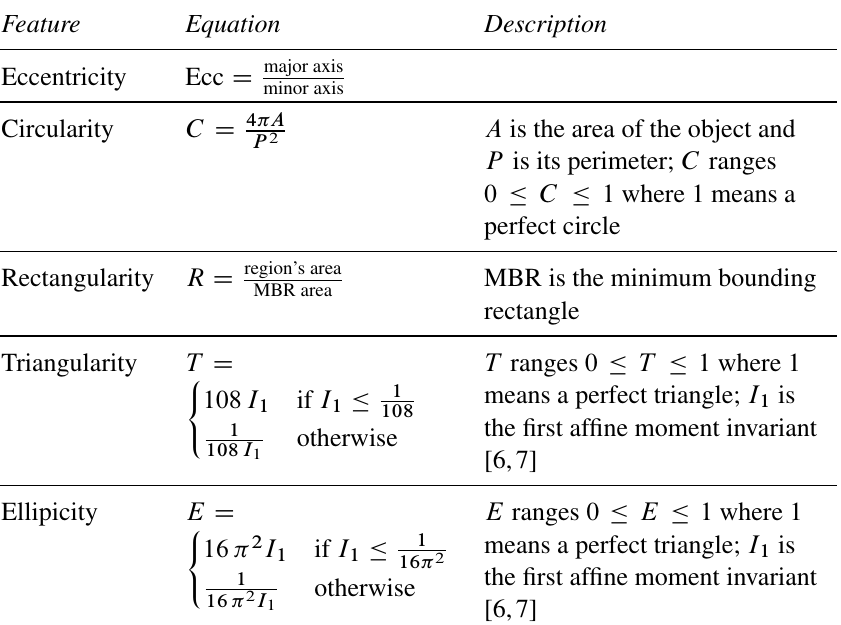
Table 2. Description of shape